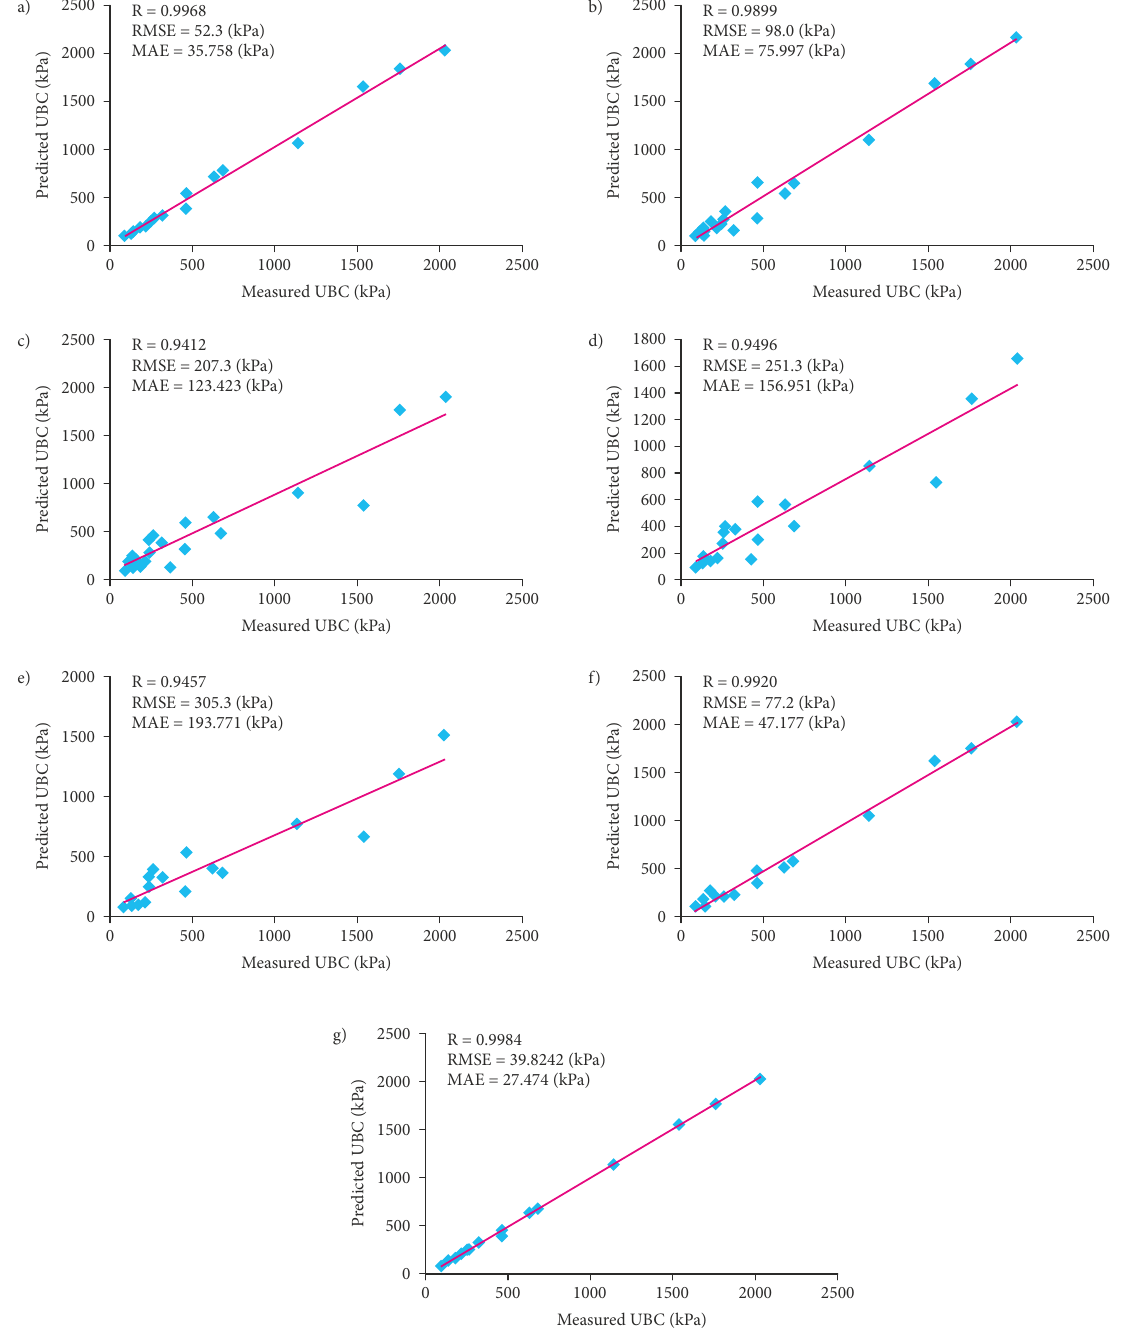
Figure 4. Prediction performance statistics of all the models & theories: (a) ANFIS; (b) FIS; (c) Meyerhof; (d) Vesic; (e) Hansen; (f) BP; (g)